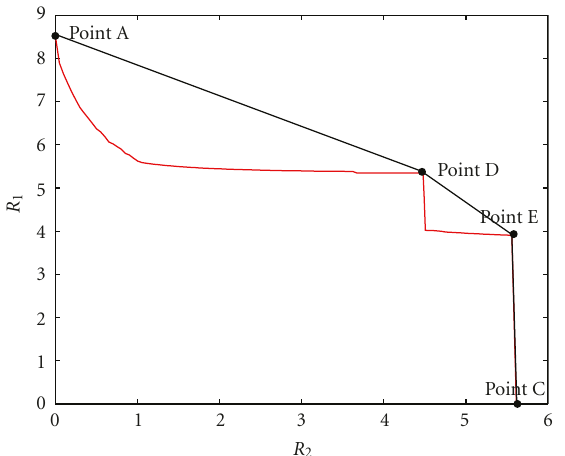
Figure 5: Achievable rate region for the precoded MIMO interfer- ence